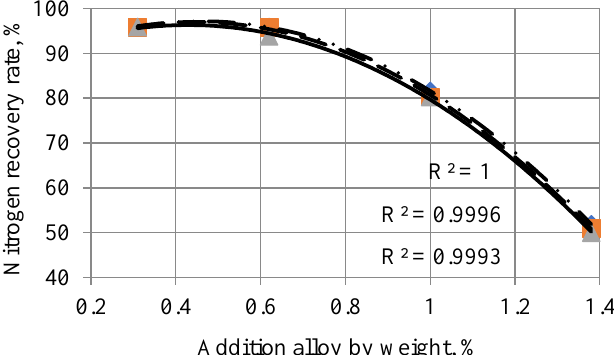
Figure 3. Nitrogen recovery rate in high manganese steel at cooling rates within the crystallization